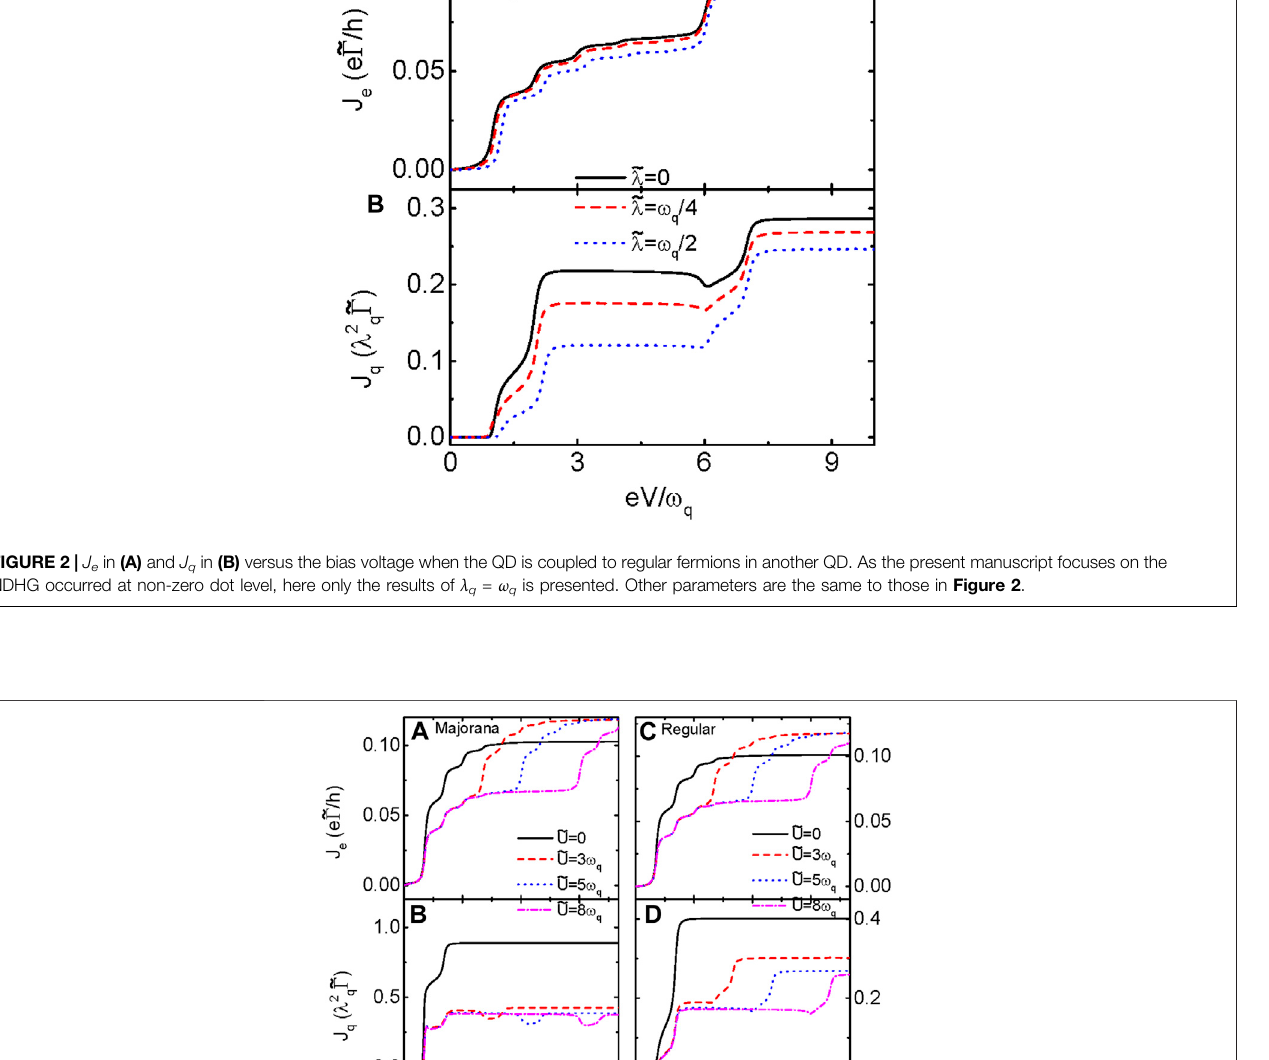
Firstly, when the dot is coupled to regular fermion (another QD), ̃ λ the heat generation decreases with increasing as shown in Figure 2B . But if the dot is coupled to MBS, the heat generation ̃ λ increases with increasing which can be seen from Figure 1D . Secondly, the NDHG in the Coulomb blockade regime is eliminated by the stronger coupling between QD and regular fermion ( Figure 2B ), whereas that in QD-MBS structure is ̃ λ enhanced. Thirdly, the NDHG around ω q + is also ̃ λ eliminated by increasing when the QD is coupled to regular